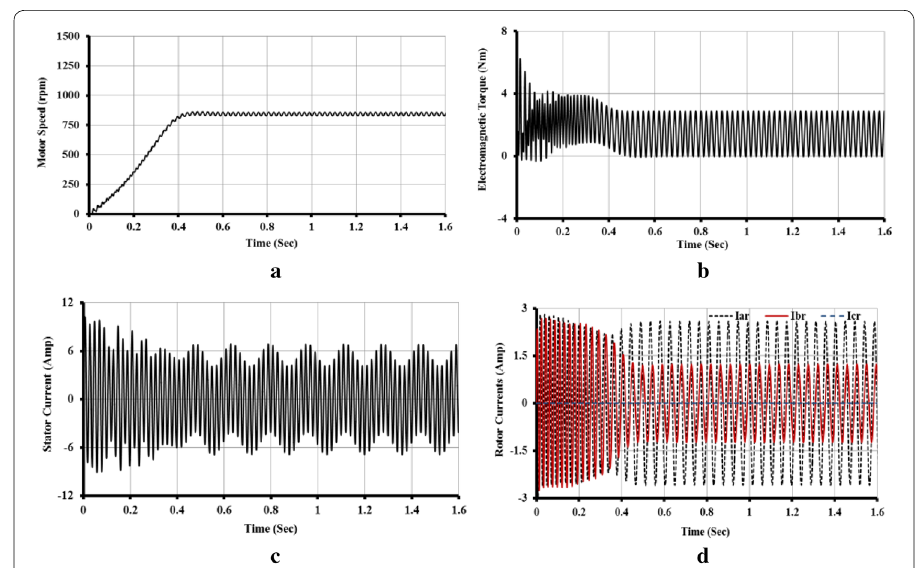
Fig. 3 Motor performance for standard delta with internal open circuit rotor phase windings connections, a motor speed, b electromagnetic torque, c stator phase current and d rotor